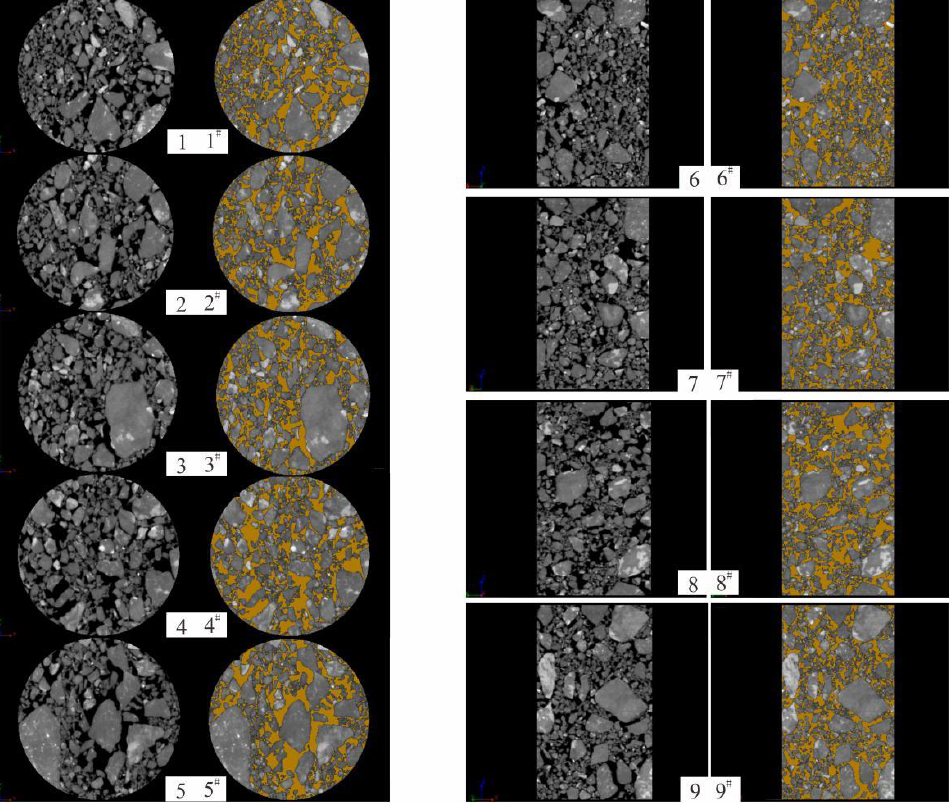
Figure 10. Transverse sectional and longitudinal sectional CT scanning before and after rendering.